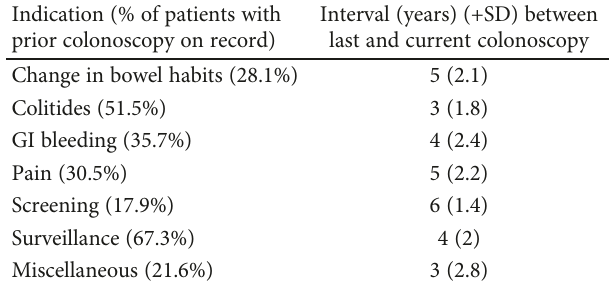
Table 3: Percent of colonoscopies performed in women for each colonoscopy indication.